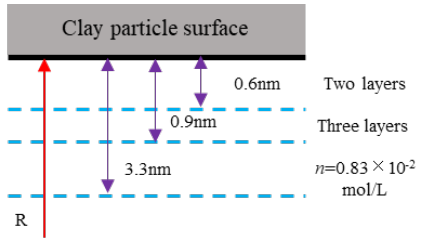
Figure 4. Tube model of soil seepage.